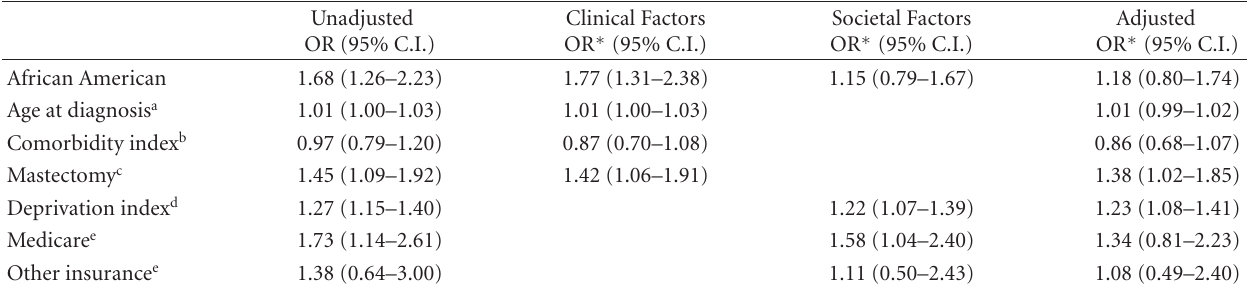
Table 5: Logistic regression analysis of predictors of the timing of adjuvant chemotherapy.